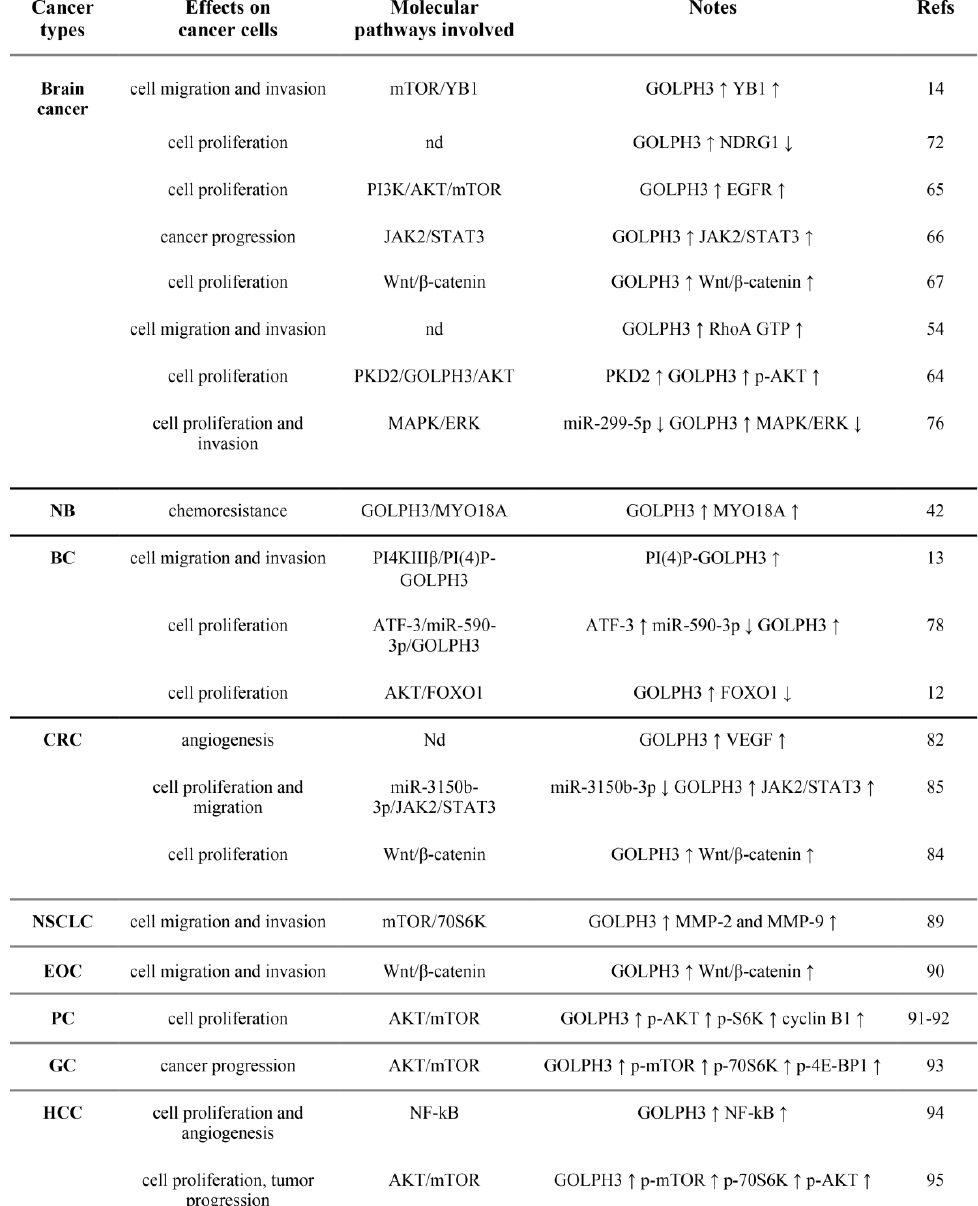
Figure 2. Effects of GOLPH3 up-regulation in solid tumors and molecular pathways involved. NB, Neuroblastoma; BC, Breast cancer; CRC, Colorectal cancer; NSCLC, Non-Small Cell Lung Cancer; EOC, Epithelial Ovarian cancer; PC, Prostate cancer; GC, Gastric Cancer; HCC, hepatocellular carcinoma. ( ↑ ),upregulation; ( ↓ ), downregulation. nd, not determined. (p-), phosphorylated.